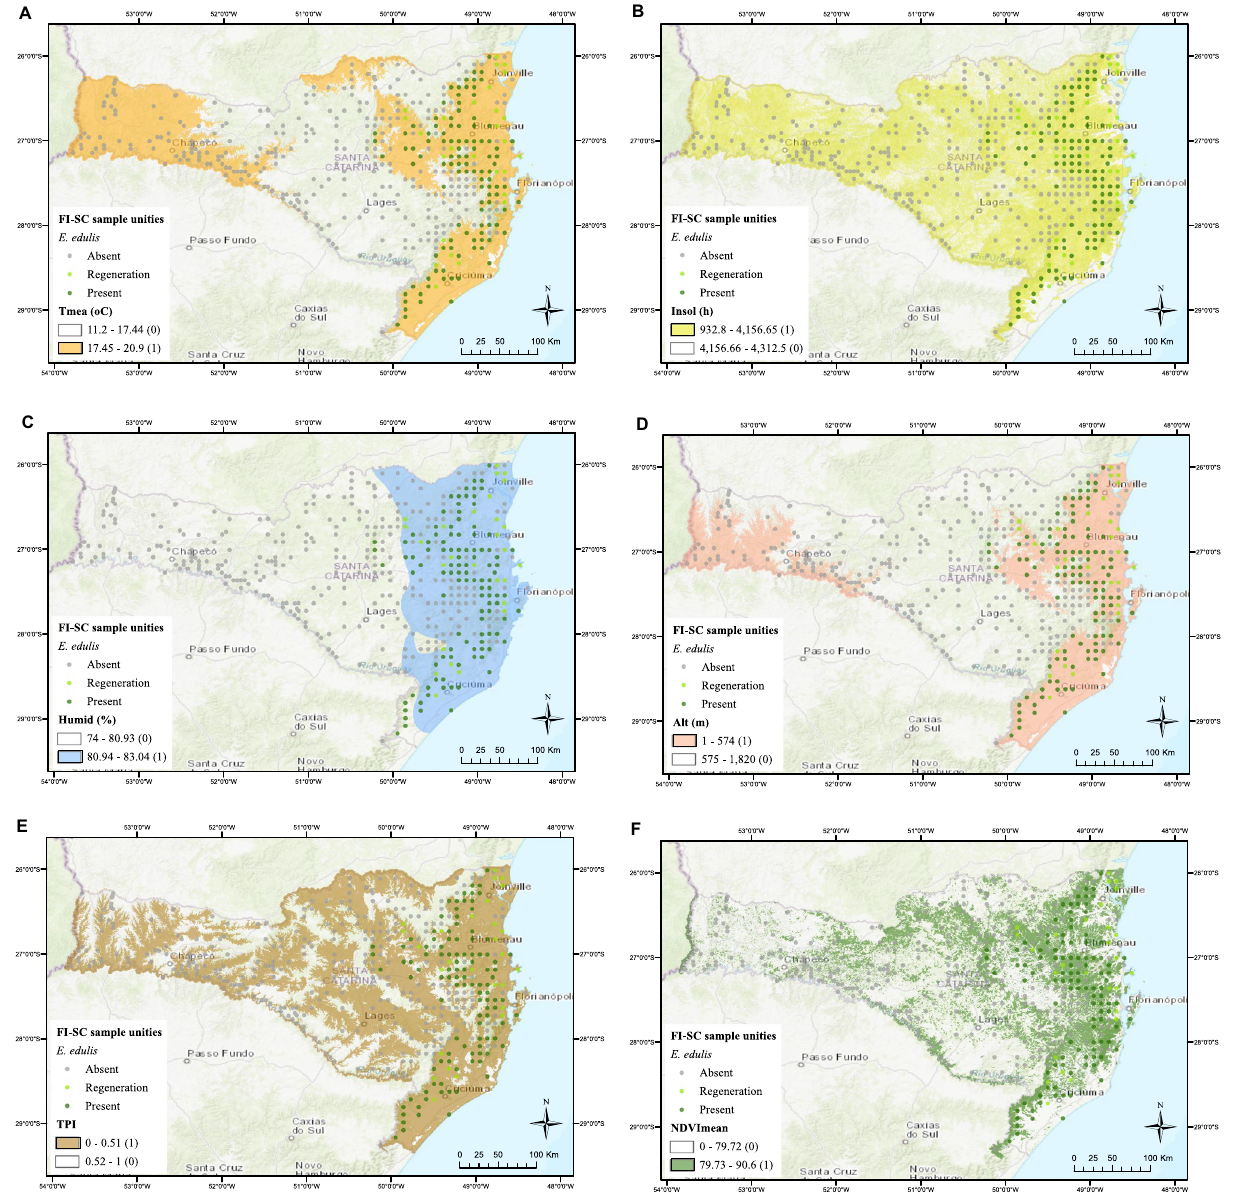
Figure 2. Spatial distribution of the Floristic Forest Inventory of Santa Catarina sampling units with E. edulis by ( A ) annual mean temperature; ( B ) annual potential insolation; ( C ) annual mean relative humidity; ( D ) altitude; ( E ) topographic position index; and ( F ) annual mean of